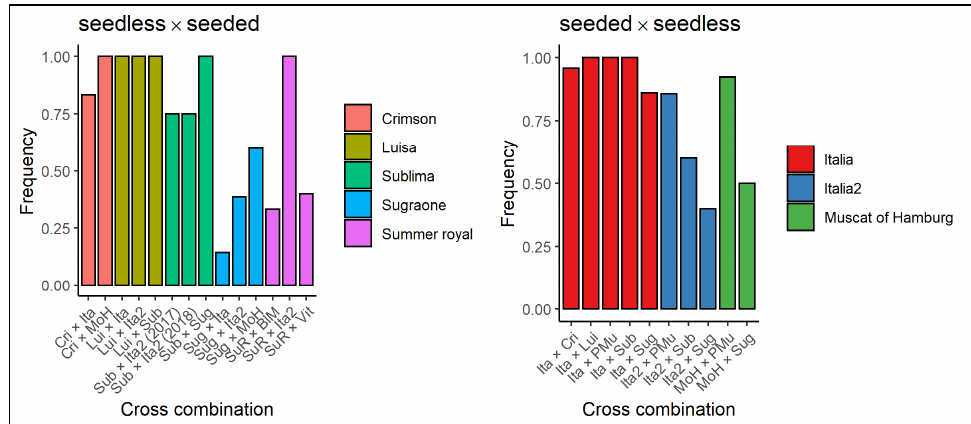
Figure 1. Ratio of the bunches collected and pollinated inflorescences: seedless × seeded; seeded × seedless.